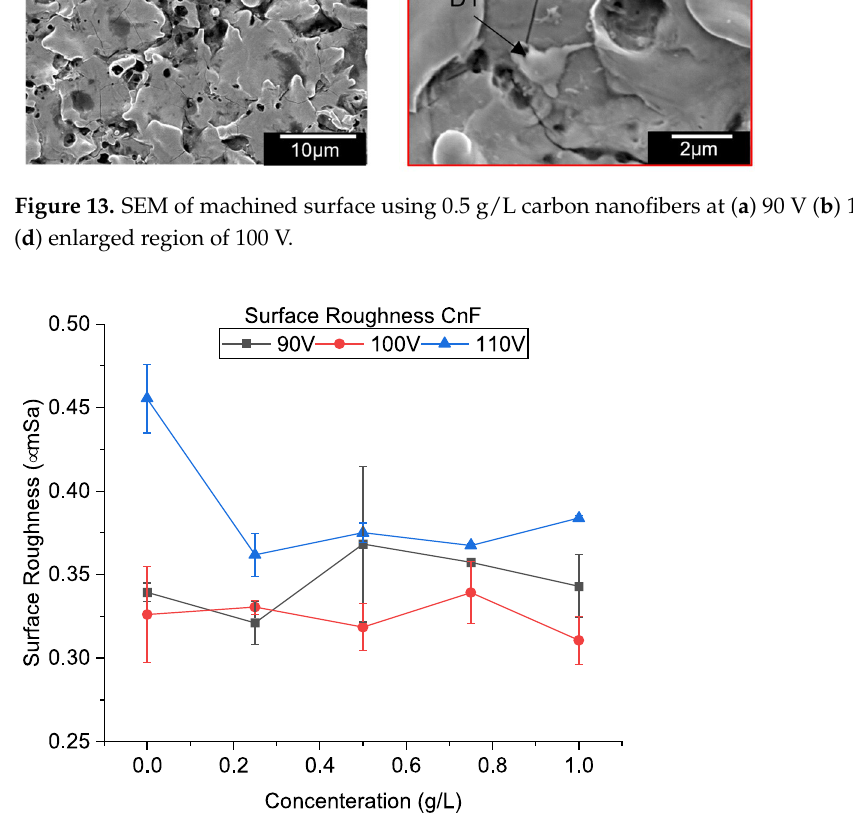
Figure 14. Surface roughness using CnF-mixed